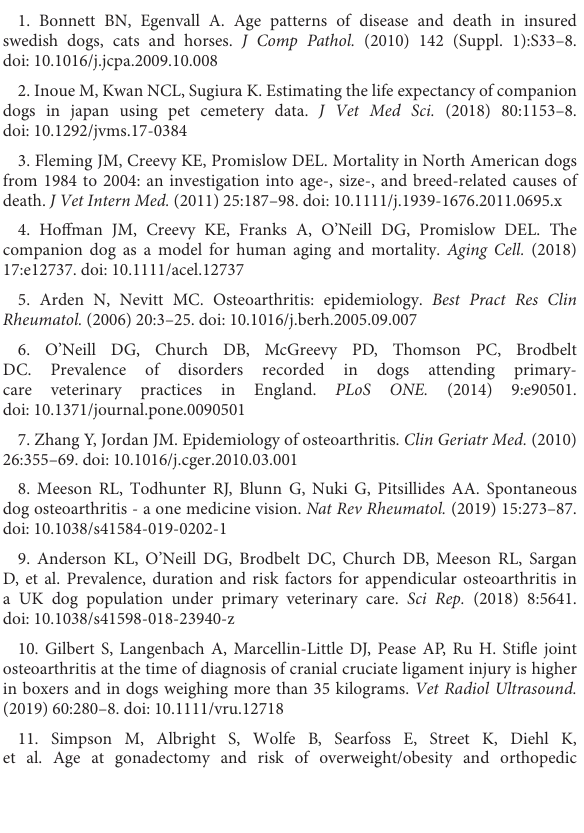
SUPPLEMENTARYTABLES1 Logistic regression parameters, p -values, and odds ratios from all analyses. SUPPLEMENTARYFIGURES1 Association of a dog ever being classified as overweight and joint supplement use. Joint supplement use was fit as a logistic regression of age and ever